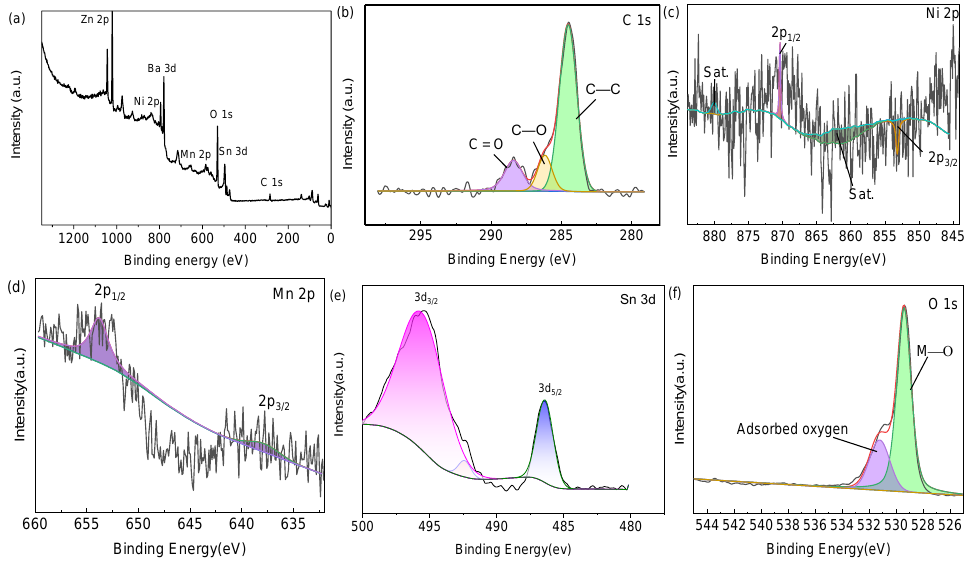
Figure 4. ( a ) SEM and corresponding mapping images of ( b ) Ni, ( c ) Mn, ( d ) Sn, and ( e ) O. ( f ) EDS spectrum. The XPS spectra of SnO 2 @Ni 6 MnO 8 were measured. The coexistence of Mn, Ni, C, O, and Sn is verified by the XPS survey spectrum (Figure 5a). The XPS spectrum of C 1s (Figure 5b) is characterized by three peaks located at 284.4, 286.2, and 288.4 eV and indexed to C — C, O — C, and C ═ O groups, respectively [39]. The Ni 2p spectrum shows four peaks at 853.4, 861.5, 870.4, and 879.9 eV, corresponding to Ni 2+ (Figure 5c). Figure 5d dis-plays the Mn 2p peaks centered at 637.7 and 653.7eV, which are ascribed to Mn 2p 3/2 and Mn 2p 1/2 , respectively. The Sn 3d spectrum (Figure 5e) verifies the existence of Sn 3d 3/2 and Sn 3d 5/2 , confirming Sn 4+ of SnO 2 [27]. Some shifts of Sn elements occurred, which may be ascribed to the impact of the Ni 6 MnO 8 coating on the surface of SnO 2 [40]. In the O 1s spectrum (Figure 5f), 529.4 eV is associated with metal–oxygen bonds, whereas the other peaks are attributed to the lattice oxygen of Ni 6 MnO 8 (530.9 eV) and surface-adsorbed oxygen (531.8 eV) [33,41,42]. Furthermore, the atomic percentages of Sn, Ni, Mn, and O are 1.46%, 0.99%, 1.72%, and 71.49%, respectively.